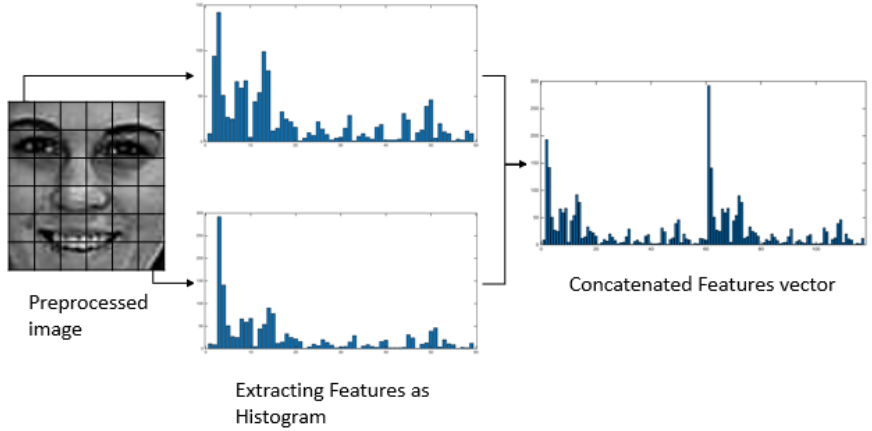
Figure 10. Converting process of selected geographical features of a